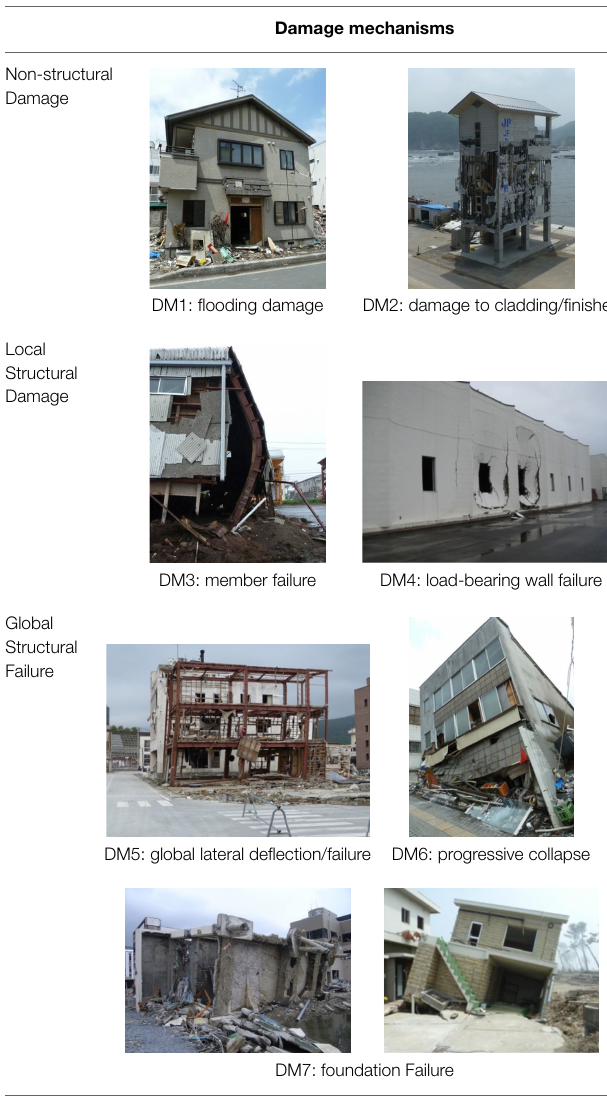
TABLE 4 | Tsunami-induced damage and failure mechanisms (photos: